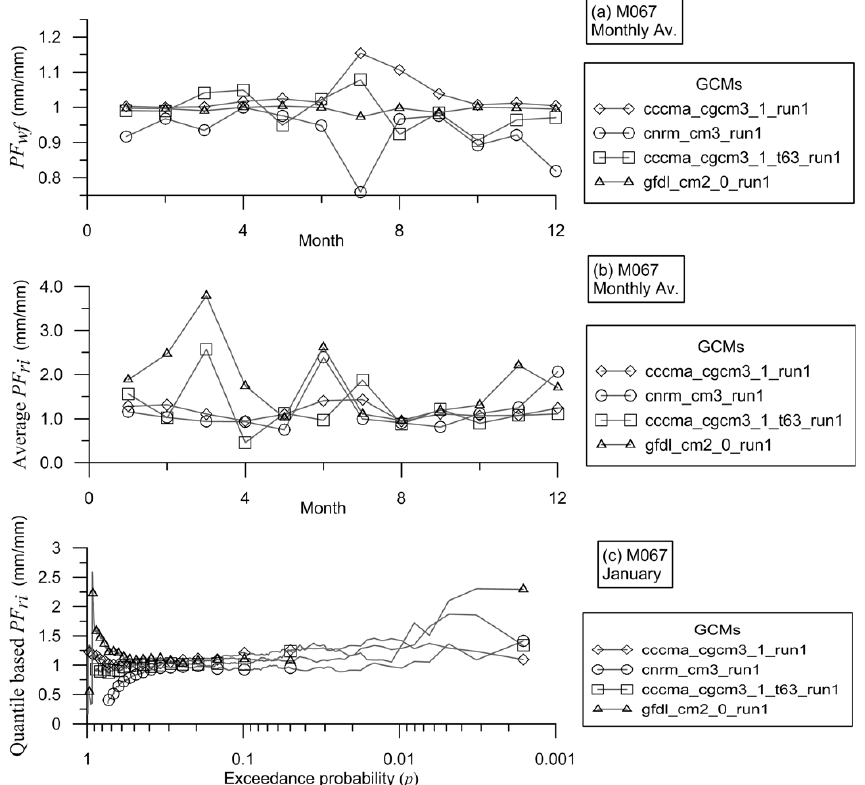
Fig. 2. (a) Perturbation factor of the wet day frequency PF wf , (b) perturbation factor of the rainfall intensity PF ri averaged for each month and (c) quantile-based PF ri for January in site M067 for the four selected GCM runs.